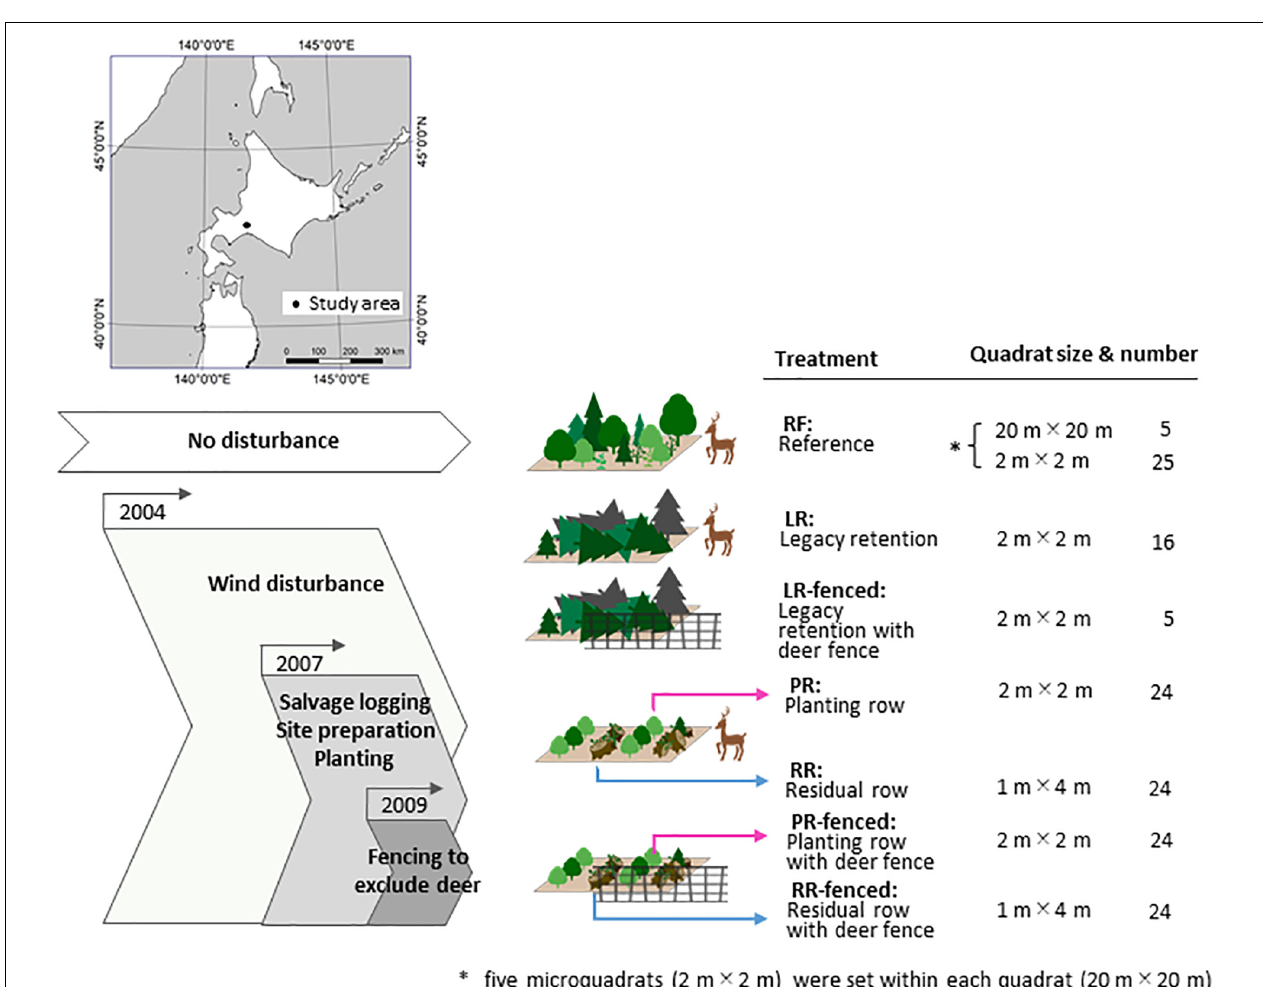
FIGURE 1 | Study area and